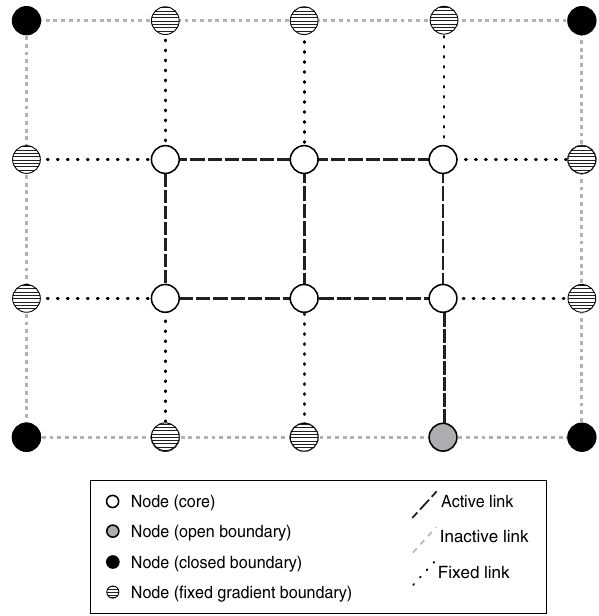
Figure 4. Simple example of Landlab RasterModelGrid, demon- strating both node and link boundary conditions. The OverlandFlow class calculates fluxes at active links, and can update the surround- ing fixed links according to these fluxes. No fluxes are calculated at inactive links. Water depth is updated at core and open boundary nodes. No calculations are performed on closed or fixed gradient boundaries. Note that RasterModelGrid cell elements and link di- rectionalities are not illustrated